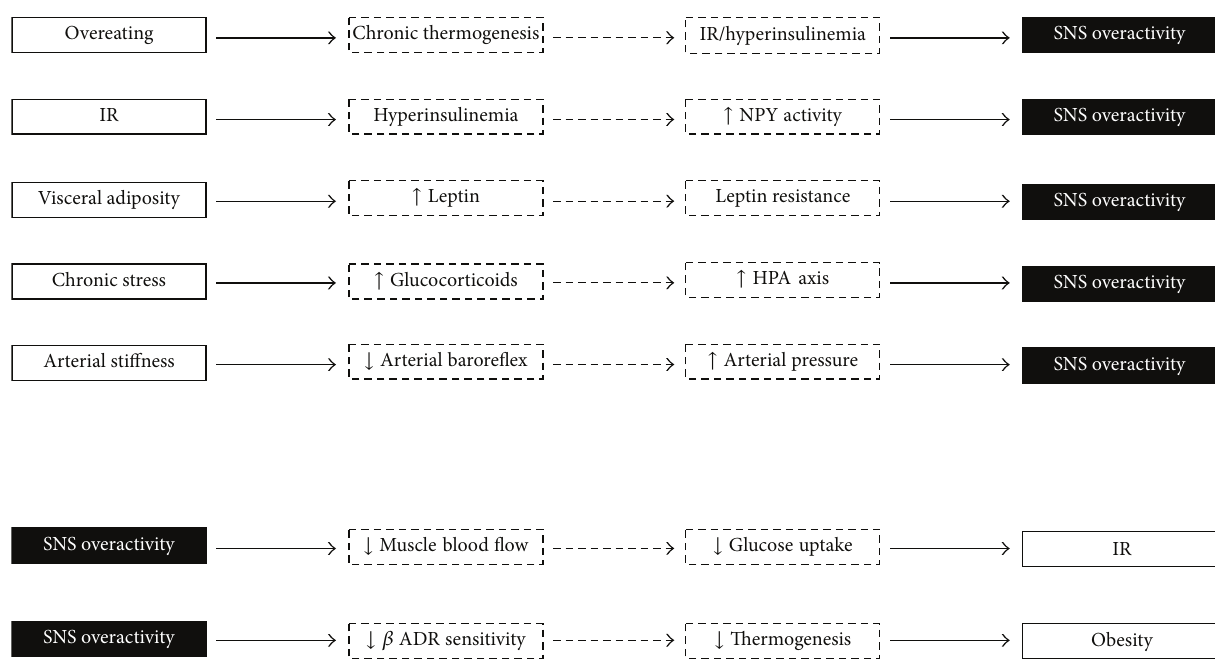
Figure 2: Schematic illustration of central sympathetic nerve overactivity as a consequence and cause of metabolic abnormalities. IR: insulin resistance; SNS: sympathetic nervous